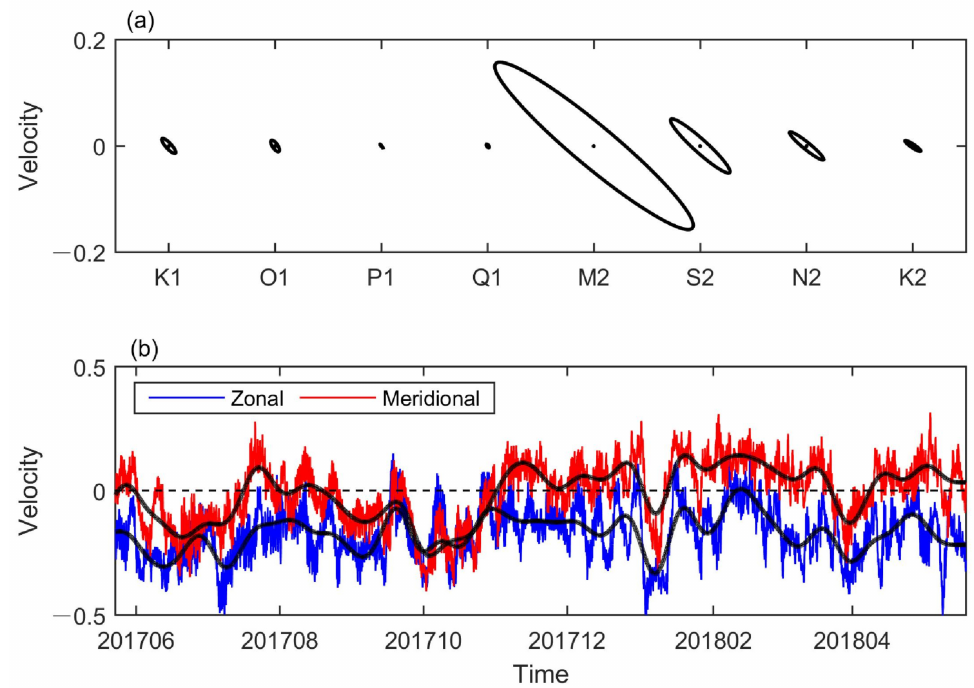
Figure 3. ( a ) Tidal ellipses of eight diurnal and semidiurnal barotropic tidal constituents. ( b ) Residual (after removing the tides) depth-averaged velocities; thick lines are the 20-day low-pass filtered velocities. (unit: m s − 1